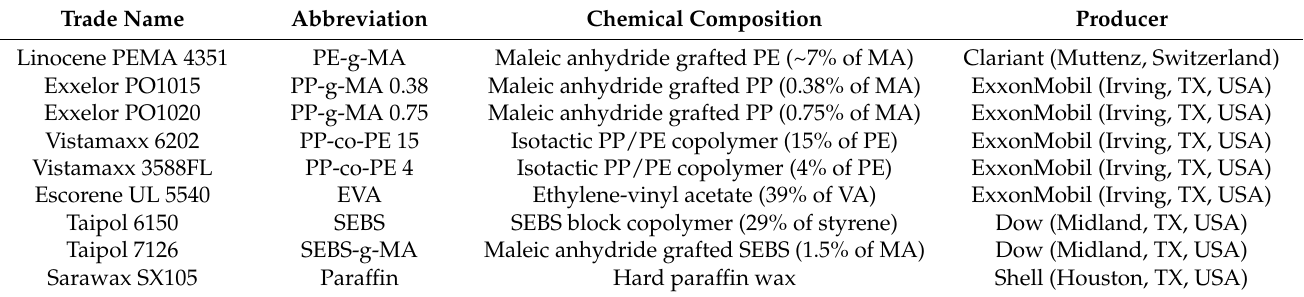
Table 1. List of compatibilizers applied in presented